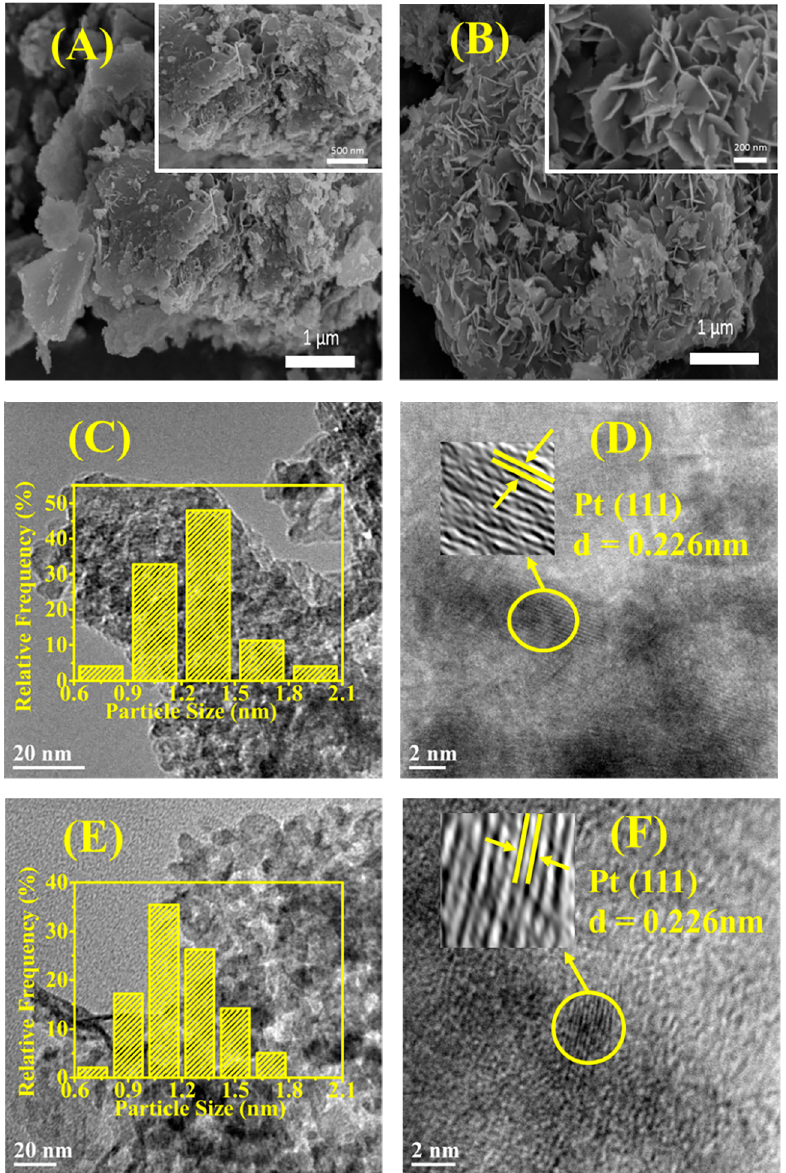
Figure 3. SEM images of PtInHTC ( A ) and PtInHTC-MgF 2 ( B ), TEM micrographs of catalysts PtInHTR ( C , D ), andPtInHTR-MgF 2 ( E , F ).